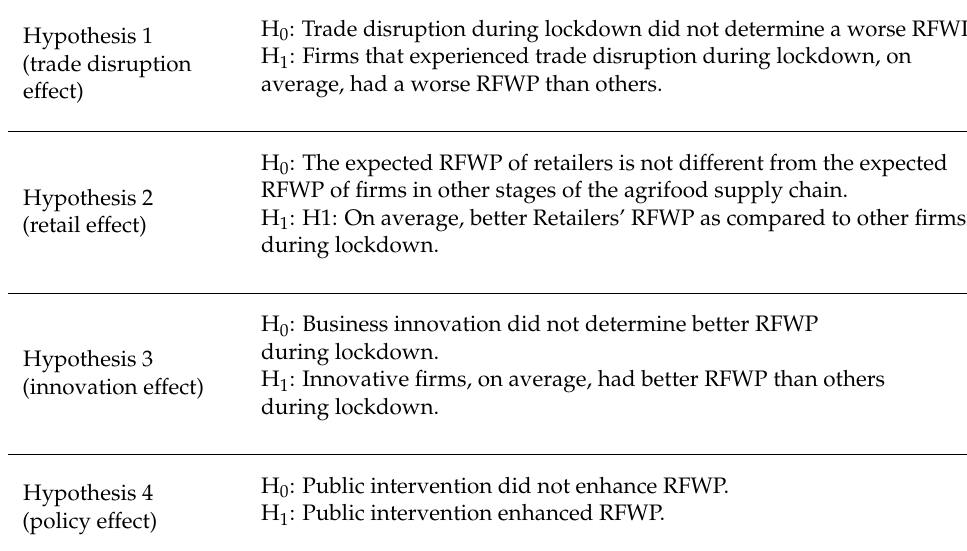
Table 2. Testable hypotheses on relative food waste performance (RFWP) during the Covid-19 lockdown